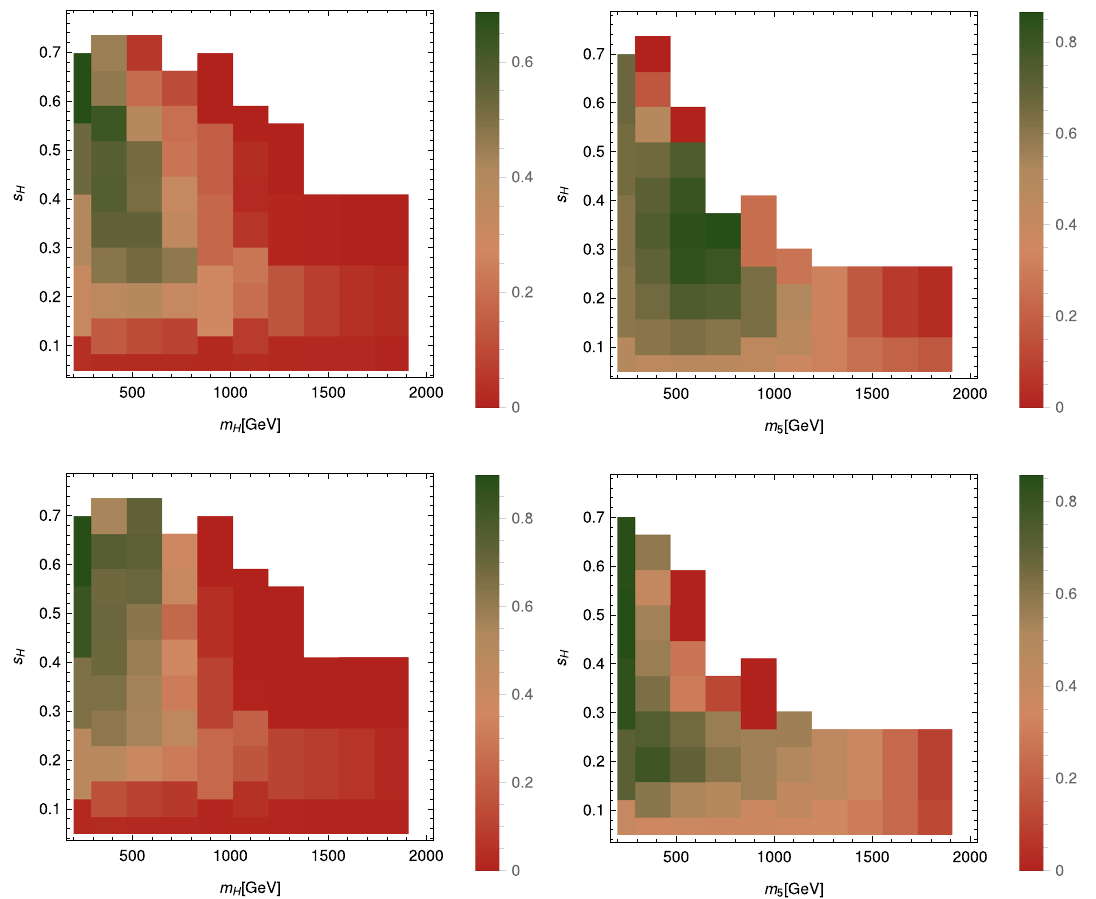
Fig. 17 Fraction of points passing the weak (first row) or strong (second row) perturbativity cut. Only points which have initially passed the HiggsBounds checks are taken into account. The left column is for Input I, the right one for Input